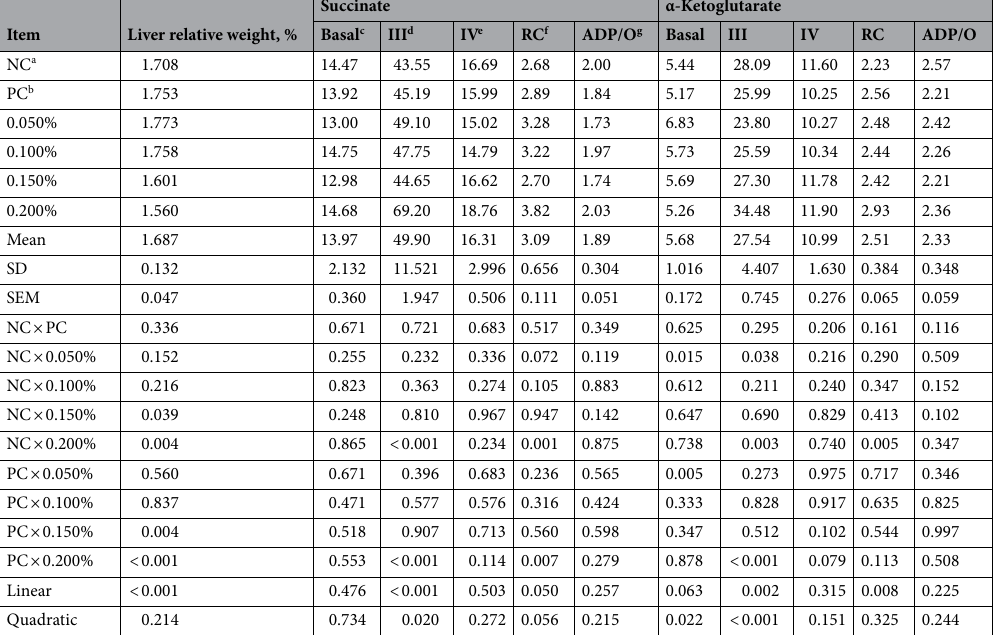
Table 1. Oxygen consumption at different states of respiration in mitochondria isolated from the liver of 75–100 kg barrows fed diets containing different levels of inosine-5-monophosphate (5 ′ -IMP) and metabolizable energy (ME), using succinate or α-ketoglutarate as respiratory substrate and stimulated by adenosine monophosphate (ADP). a Negative control (0.00% 5 ′ -IMP and 3200 kcal ME/kg). b Positive control (0.00% 5 ′ -IMP and 3300 kcal ME/kg). c Oxygen consumption before ADP addition (substrate or basal). d Oxygen consumption shortly after ADP addition (state III). e Oxygen consumption after stopping ADP stimulation (state IV). f Respiratory control (RC) calculated by the relationship between states III/IV. g ADP/O ratio determined as proposed by Chance and Williams (1955).